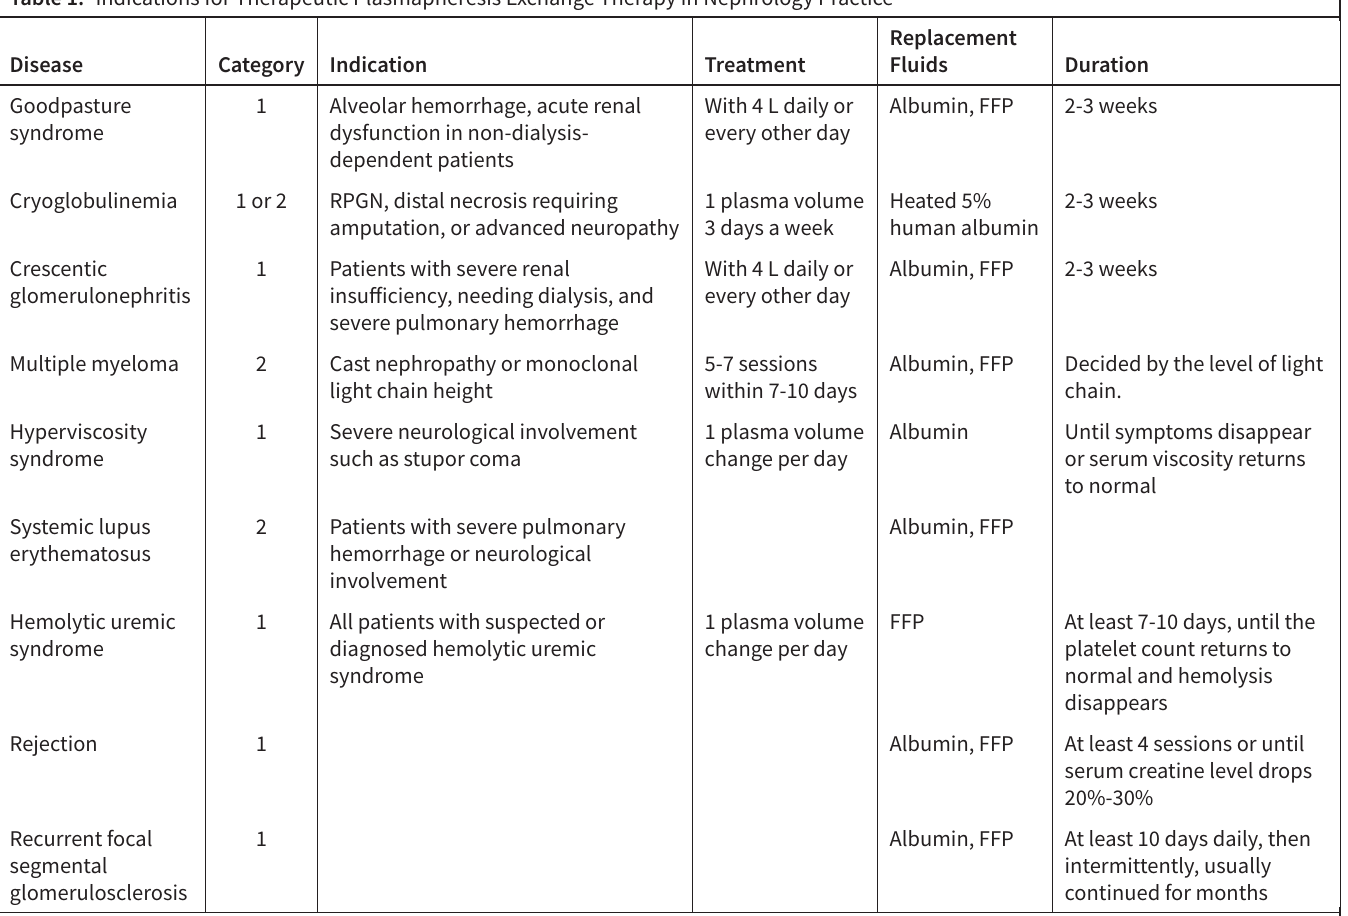
Table 1. Indications for Therapeutic Plasmapheresis Exchange Therapy in Nephrology Practice